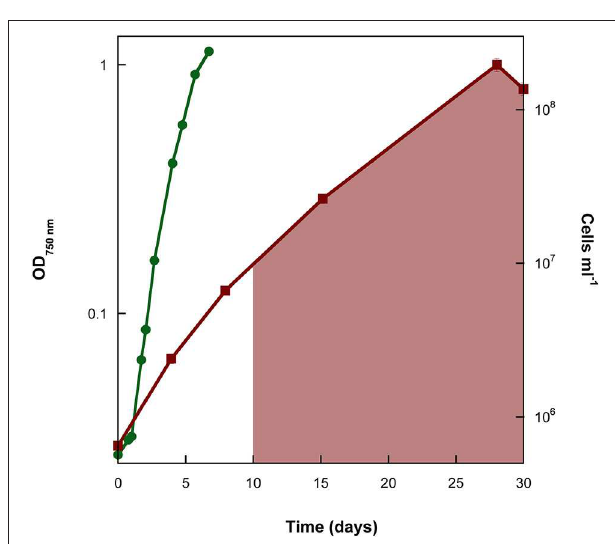
FIGURE 2 | Cell counts of a representative replicate of the experiment where the marine cyanobacterium Synechococcus PCC 7002 was cultivated under conditions that began anoxic with 4800 µ M Fe(II). Cell numbers reach similar values to the experiment with 7.5 µ M Fe(II) once all of the Fe(II) has been oxidized (shaded area denotes time when Fe(II) was no longer detectable by ferrozine).